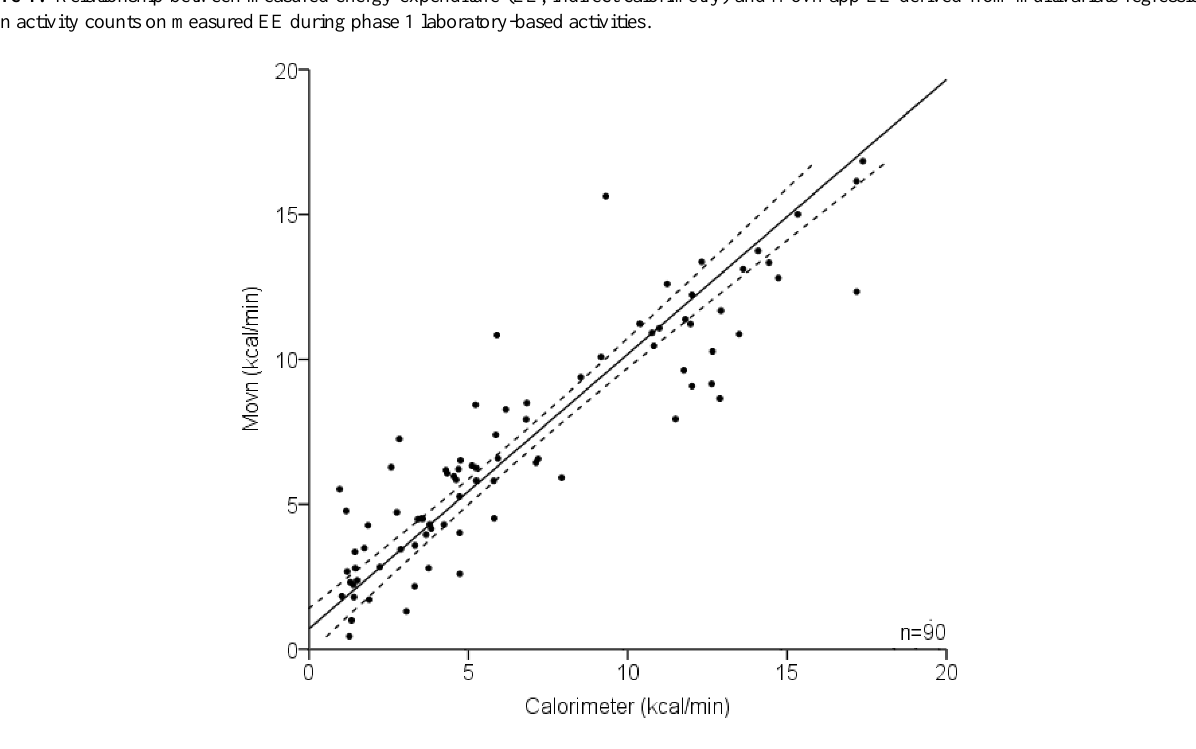
Activity (counts/min)MET b rangeActivity intensity level a